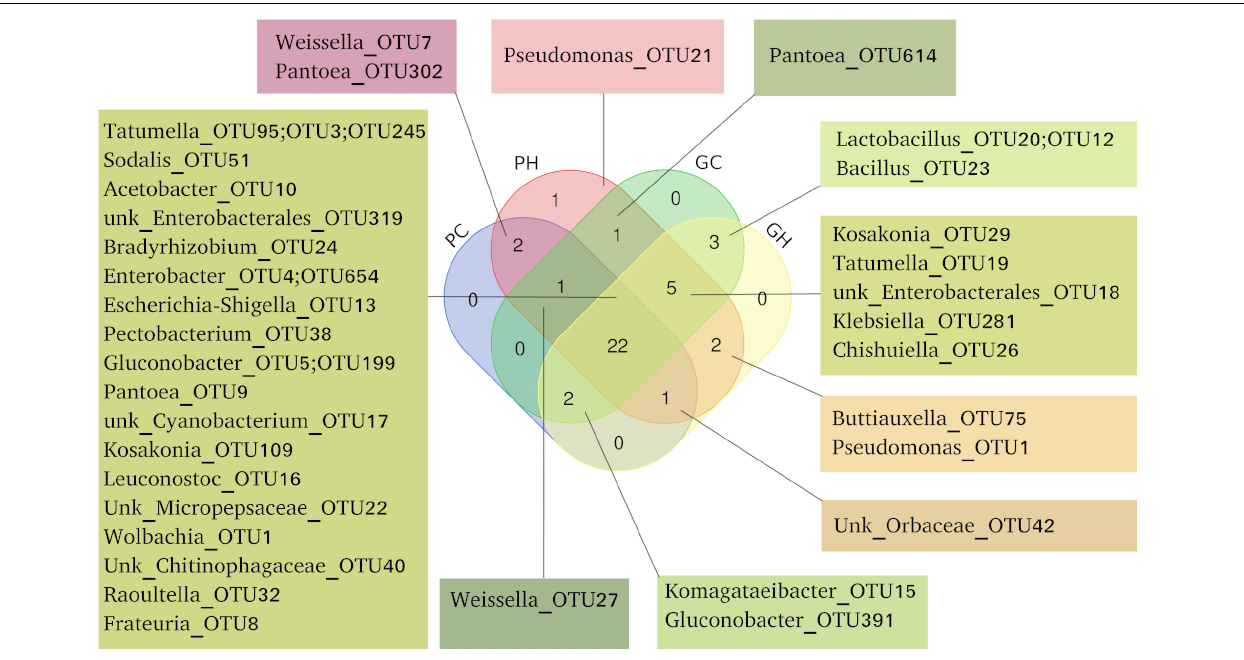
FIGURE 3 | Shared and unique OTUs found in the gut microbiome of Anastrepha fraterculus larvae. Venn diagram showing OTUs shared across all four origins and hosts combinations (PC, peach sampled in Concordia; PH, peach sampled in Horco Molle; GC, guava sampled in Concordia; GH, guava sampled in Horco Molle), three and two of them. OTUs are presented in detail, including number and taxonomic identification according to Silva database.